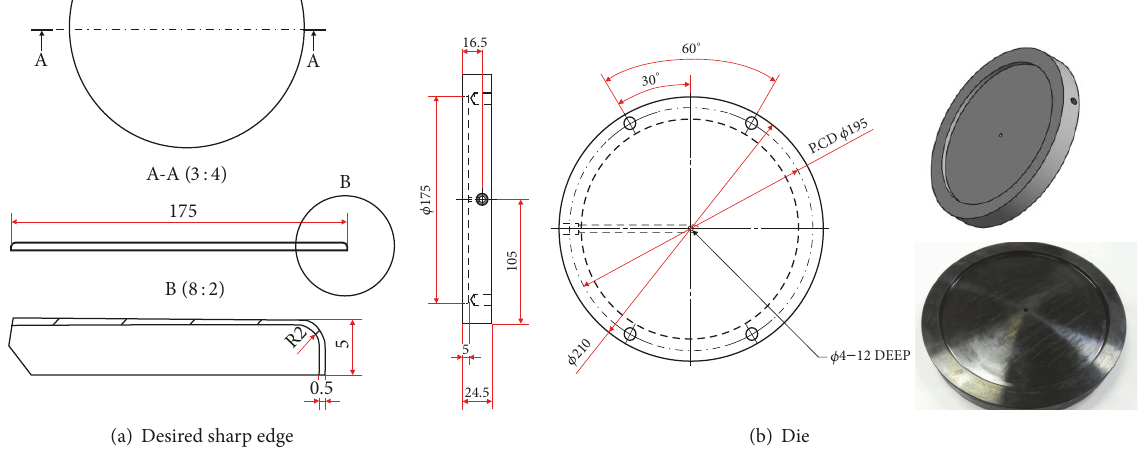
Figure 11: Target and die for sharp edge